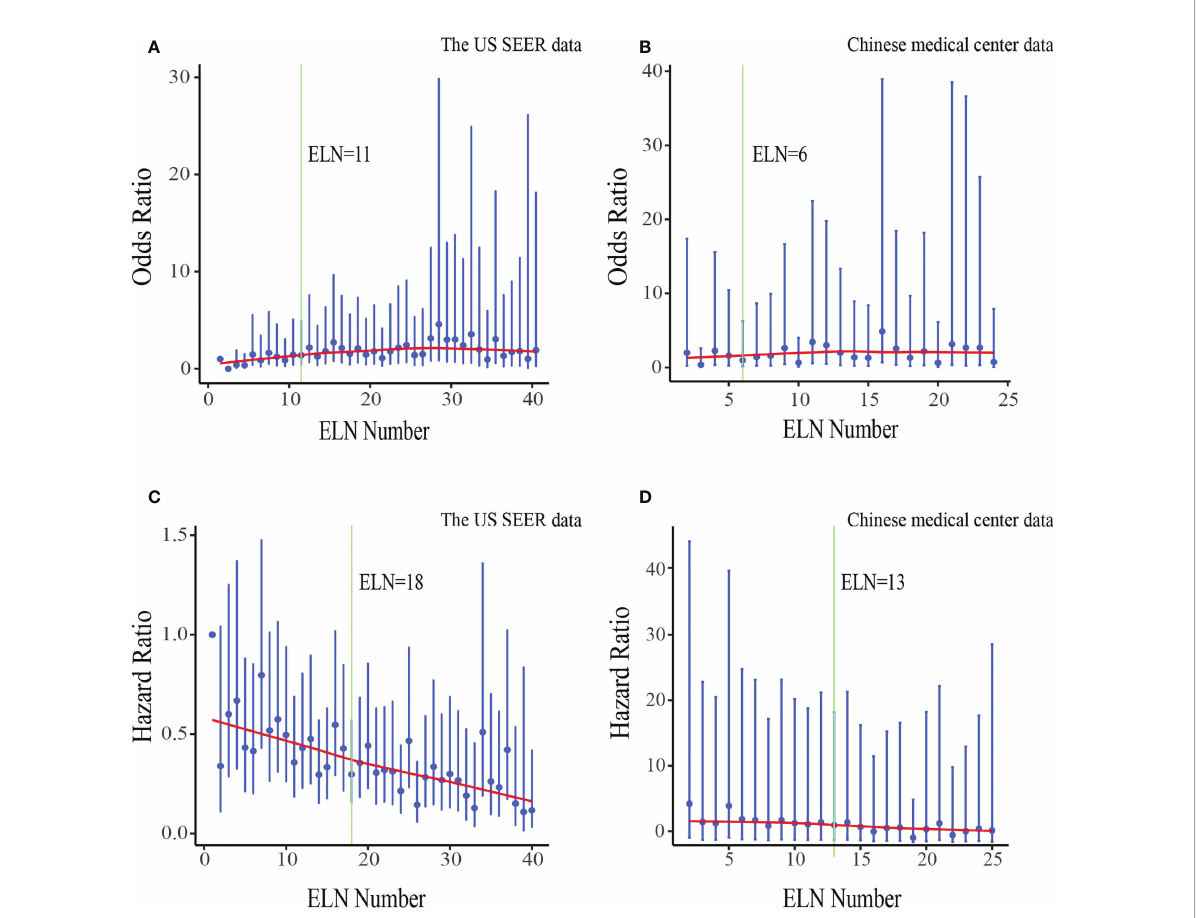
FIGURE 3 Associations of ELN number with odds ratio(OR) of negative-to-positive node stage migration and hazard ratio(HR) of overall survival in the US data (A, C) and Chinese data (B, D) . ORs and HRs and the corresponding 95% con fi dence intervals are shown in blue. LOWESS smoother- fi tted curves are shown in red. The structural breaks are shown in green. ELN, Examined lymph